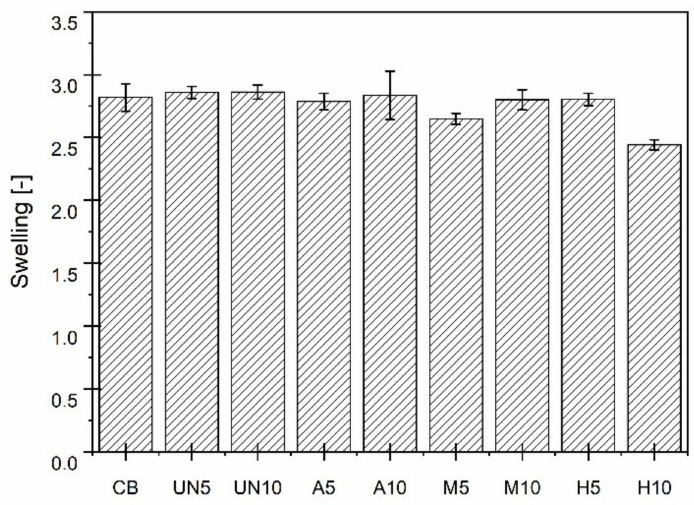
Figure 9. Equilibrium swelling of the rubber vulcanizates studied in